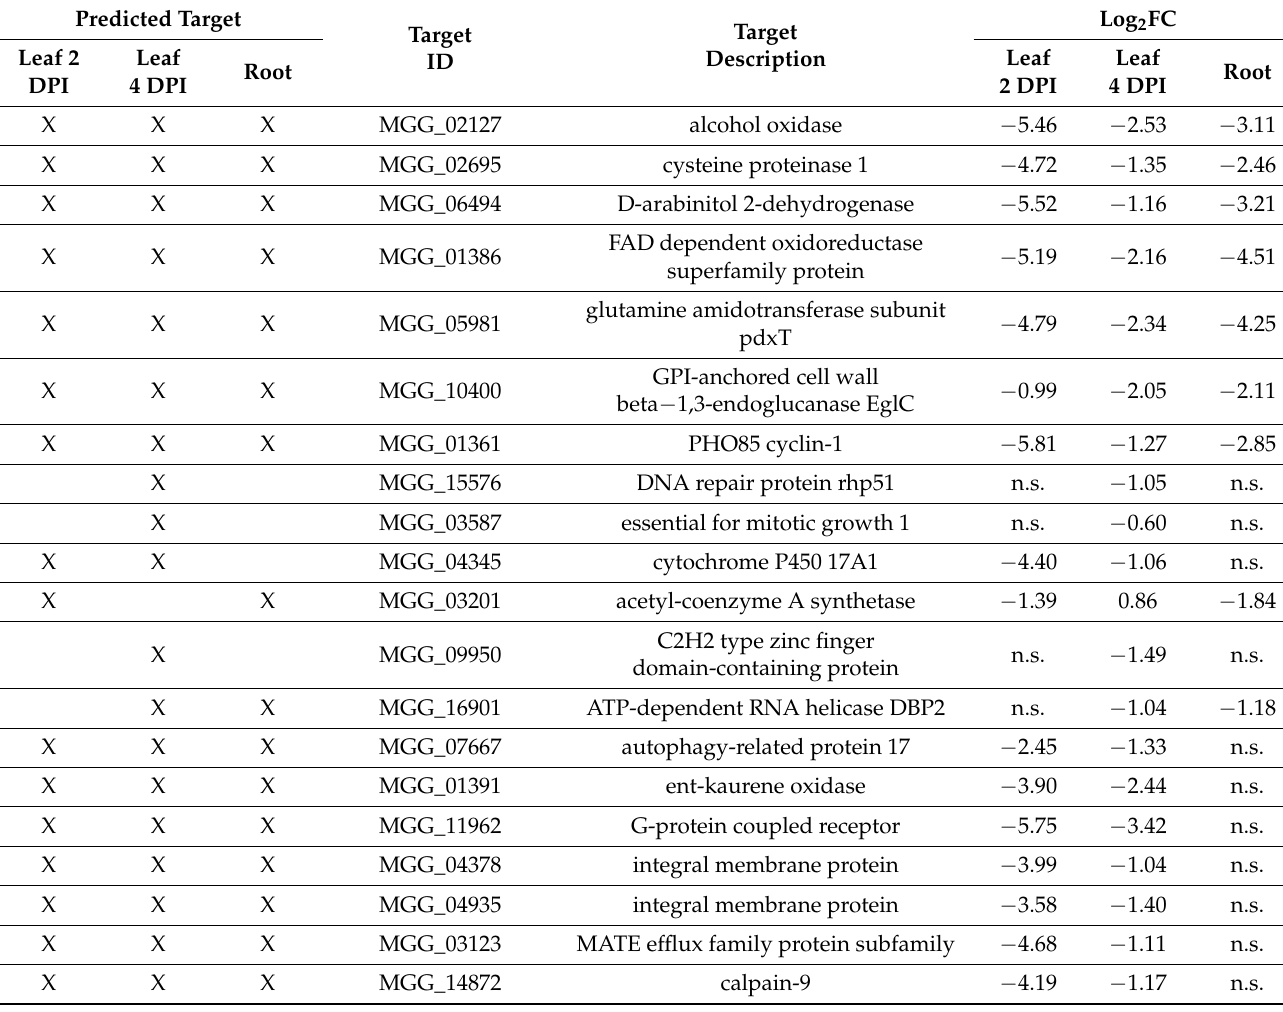
Table 7. Selected M. oryzae mRNA targets of predicted cross-kingdom B. distachyon sRNAs from leaf and root setups. Predicted